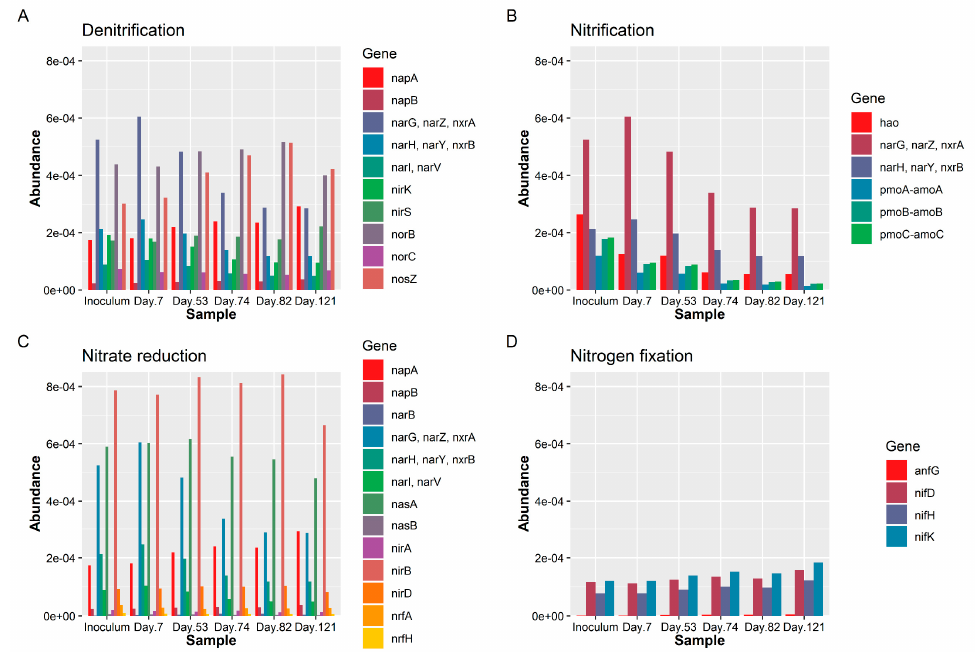
Figure 5. Gene abundance for nitrogen metabolism. ( A ) The abundance of nitrification-related genes. ( B ) The abundance of denitrification-related genes. ( C ) Abundance of nitrification-related genes. ( D ) The abundance of nitrogen-fixation-related genes.